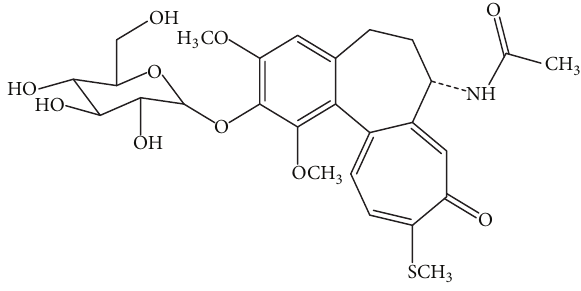
Figure 1: Chemical structure of